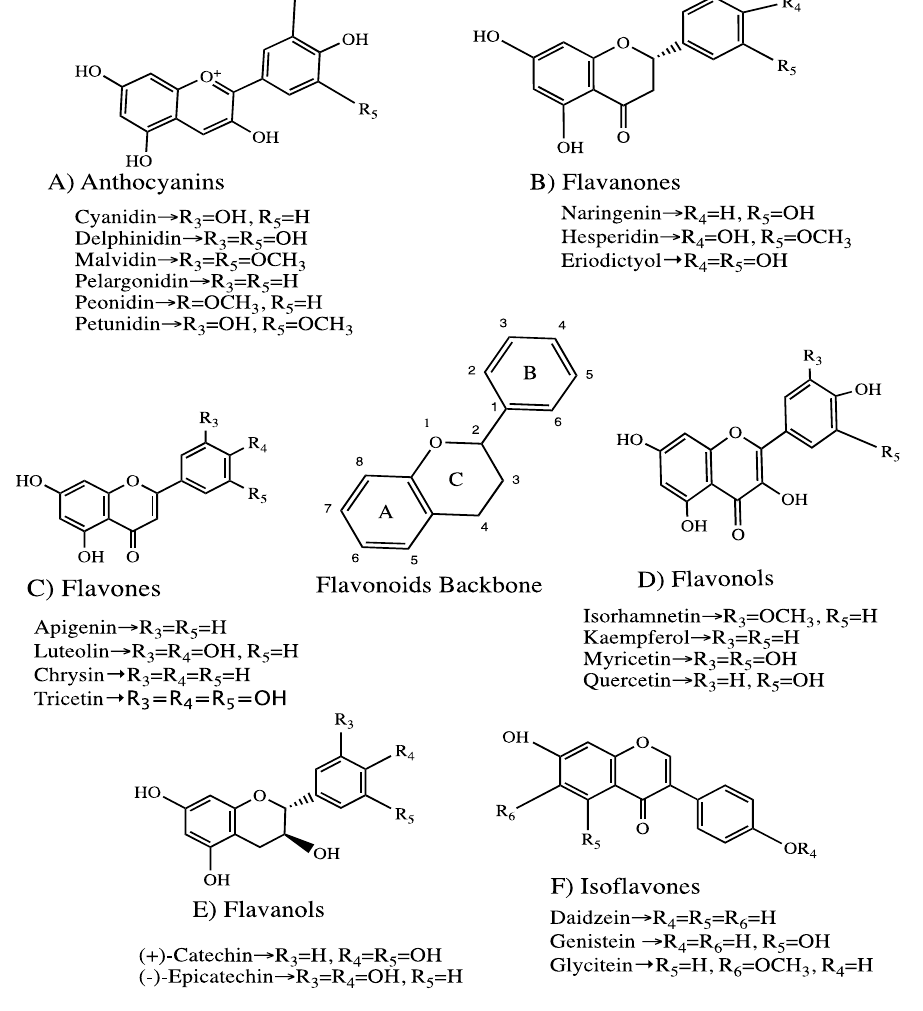
Figure 1. Common structures of flavonoid classes and their derivative compounds (Chemical structures are drawn using ChemDraw software). ( A ) Anthocyanins; ( B ) Flavanones; ( C ) Flavones; ( D ) Flavonols; ( E ) Flavanols; ( F )